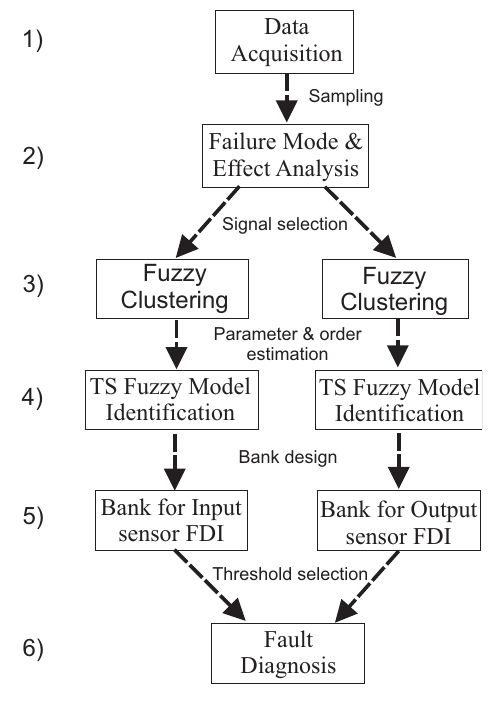
Figure 6. Sketch of the complete design